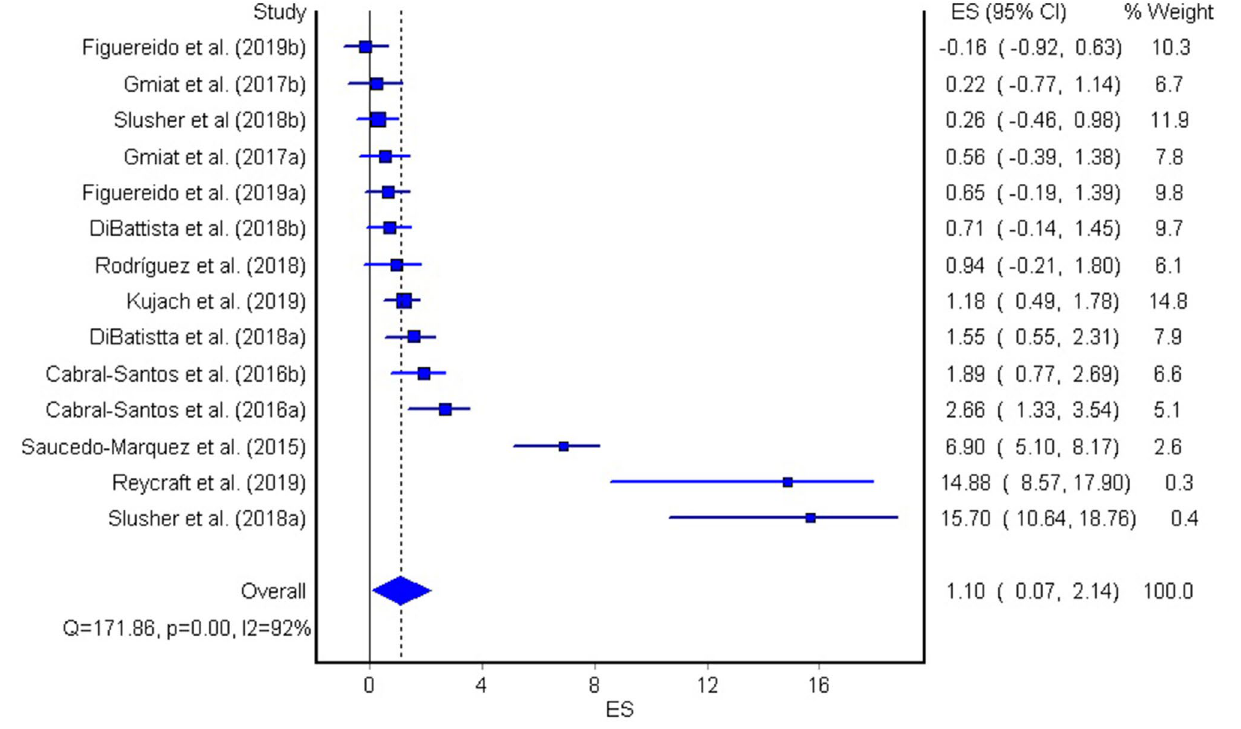
Figure 3. The effect of acute interval training (IT) on circulating BDNF concentration. The lines indicate 95% confidence intervals (CI), and the square reflect the standardized differences (SMD) for each study. The diamond in the forest plot indicates the overall effect size (ES).